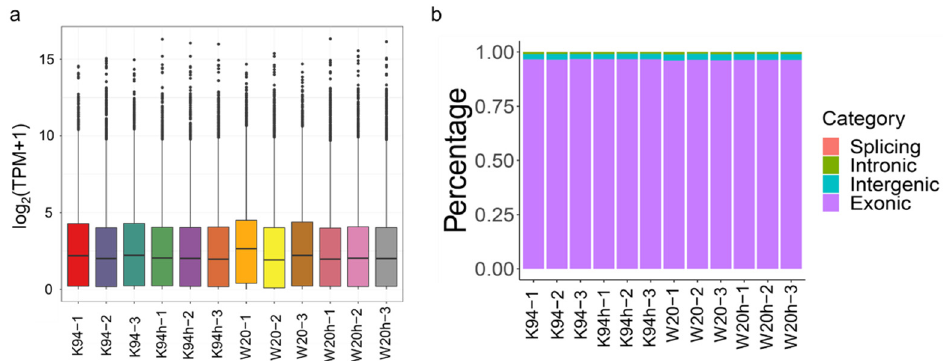
Figure 3. The quality and quantity of the RNA sequencing: ( a ) boxplot of the expressions of 12 samples; ( b ) categorization